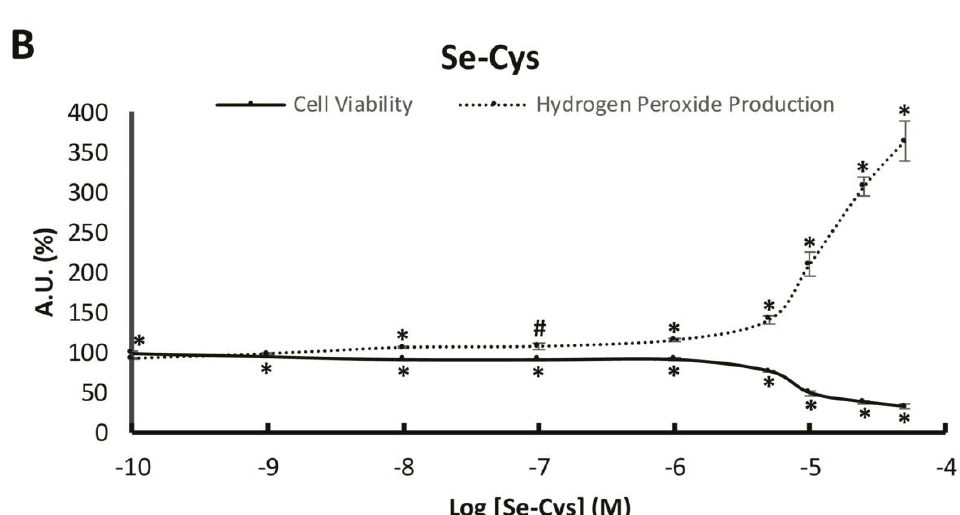
Figure 1. Cell viability and hydrogen peroxide production in MCF-7 breast cancer cells after selenomethionine or selenocystine treatment. ( A ) The cells were treated with vehicle or with increasing concentrations of selenomethionine (from 1 nM to 1 mM) for 48h. ( B ) The cells were treated with vehicle (data not shown) or with increasing concentrations of selenocystine (from 100 pM to 50 µM) for 48h. Solid line represents the cell viability and pointed line represents hydrogen peroxide production. Points in lines represent means and error bars represent SEM ( n = 6). The value of control cells was set at 100% (data not shown) and the rest of values were calculated referenced to the control set at 100%. * Significant differences between selenoamino acid treated and control cells (Student’s t-test; p ≤ 0.05). # Significant differences between selenoamino acid treated and control cells (Student’s t-test; p ≤ 0.1). AU: Arbitrary Units.